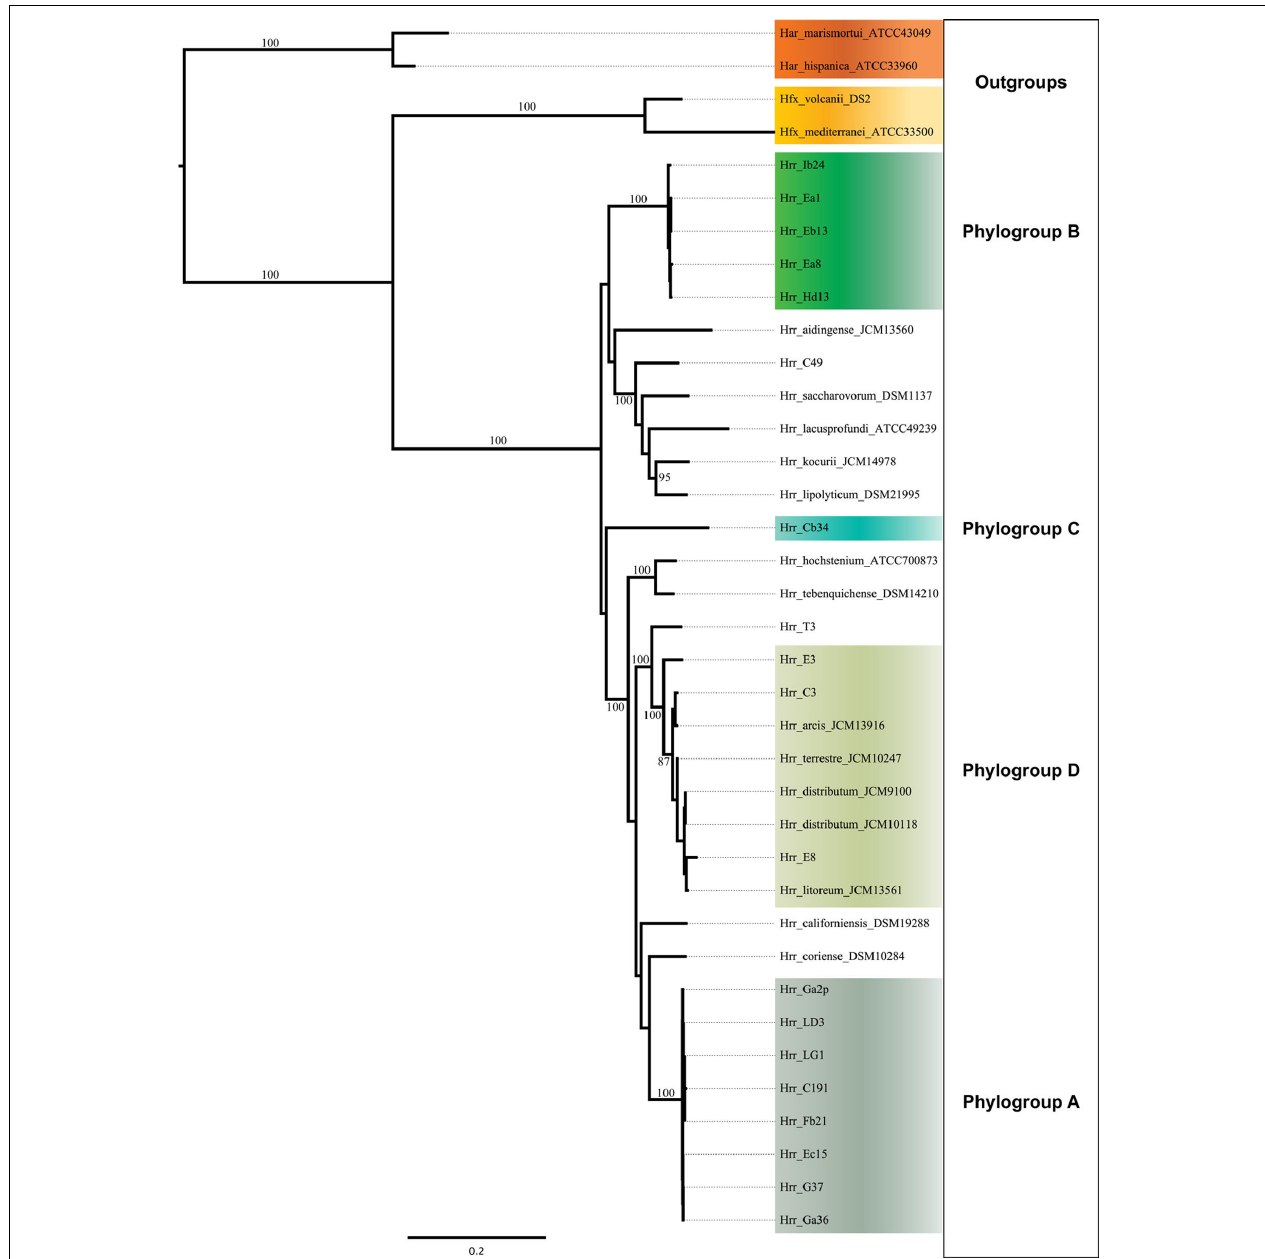
FIGURE 2 | Maximum-likelihood tree made from the concatenated DNA sequences of five housekeeping genes ( atpB, ef-2 , glnA , ppsA , and rpoB ). Support values on branches are bootstrap replicates. Bootstraps values below 70 are not displayed.